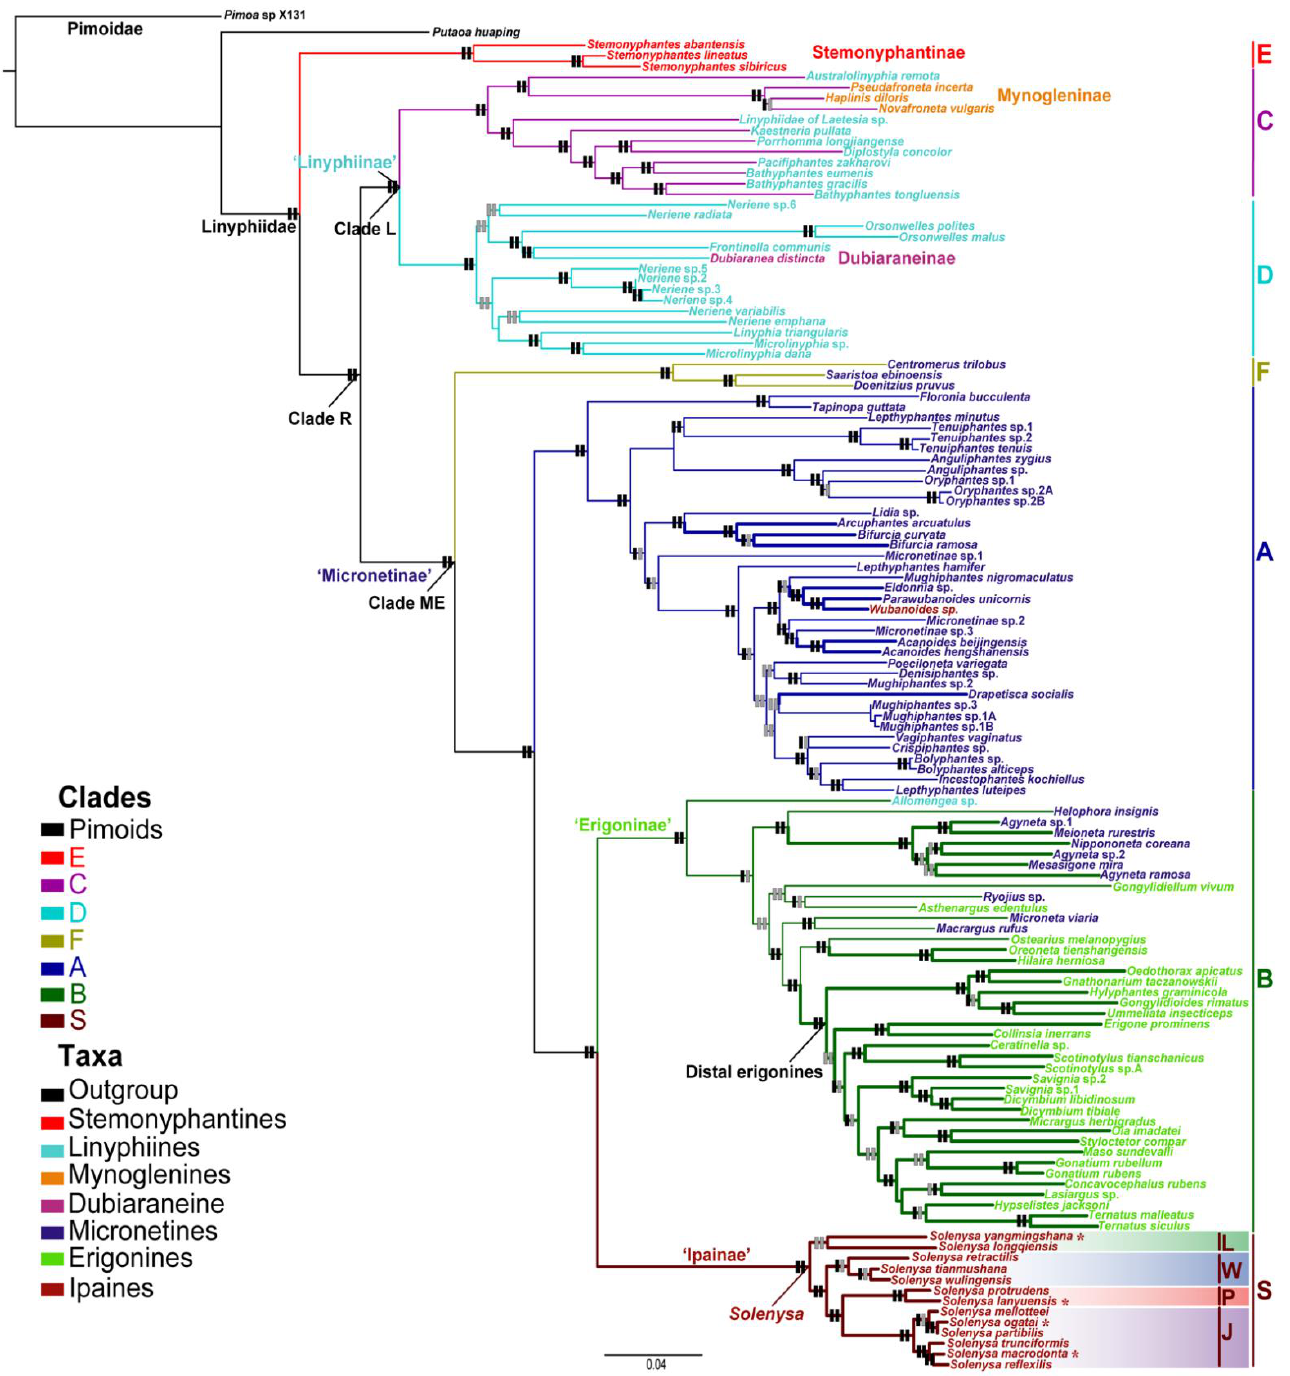
Figure 2. ML tree of linyphiid phylogeny with proportional branch lengths. Branches in color show the seven major clades within Linyphiidae. Taxa names in color indicate their current subfamilial placements. Thickened blue branches in clade A indicate taxa having a movable epigynum. Thickened green branches in clade B indicate taxa having a desmitracheate system. Thickened branches in clade S indicate all Solenysa taxa having both movable epigynum and an intermediate type tracheate system. Bars on branches indicate corresponding node supports of the main clades: the anterior show the maximum likelihood bootstrap (BS) and the posterior Bayesian posterior probability (PP), respectively. Bars in black indicate BS > 80%; PP > 0.95; bars in grey BS < 80%, PP < 0.95. Trees with all the node supports are included as Supplementary Material.